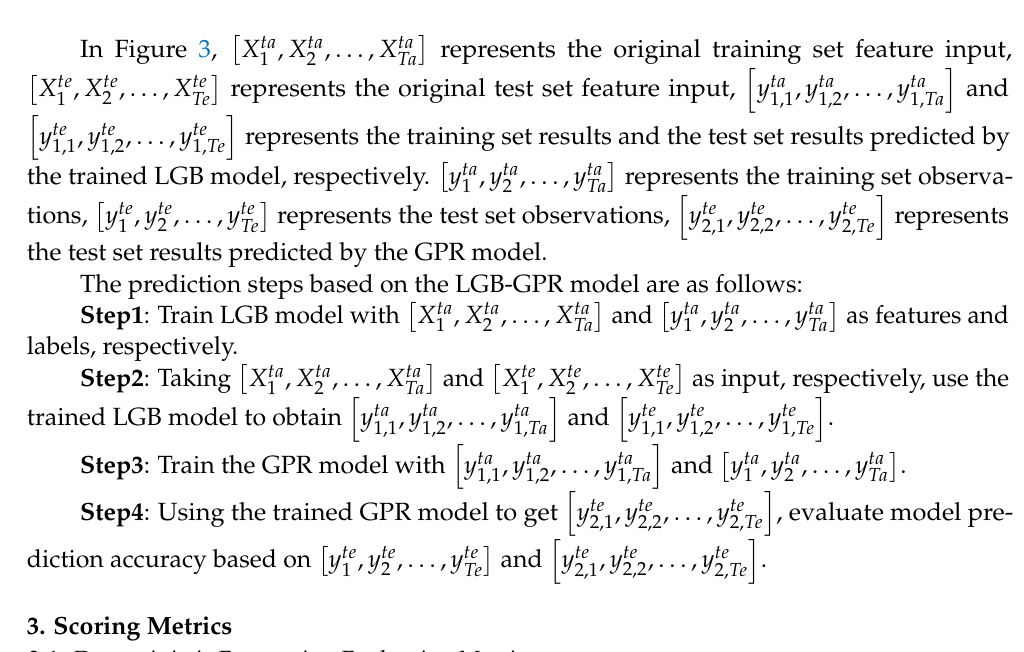
(cid:2) (cid:3) X ta , X ta , . . . , X ta represents the original training set feature Ta 2 1